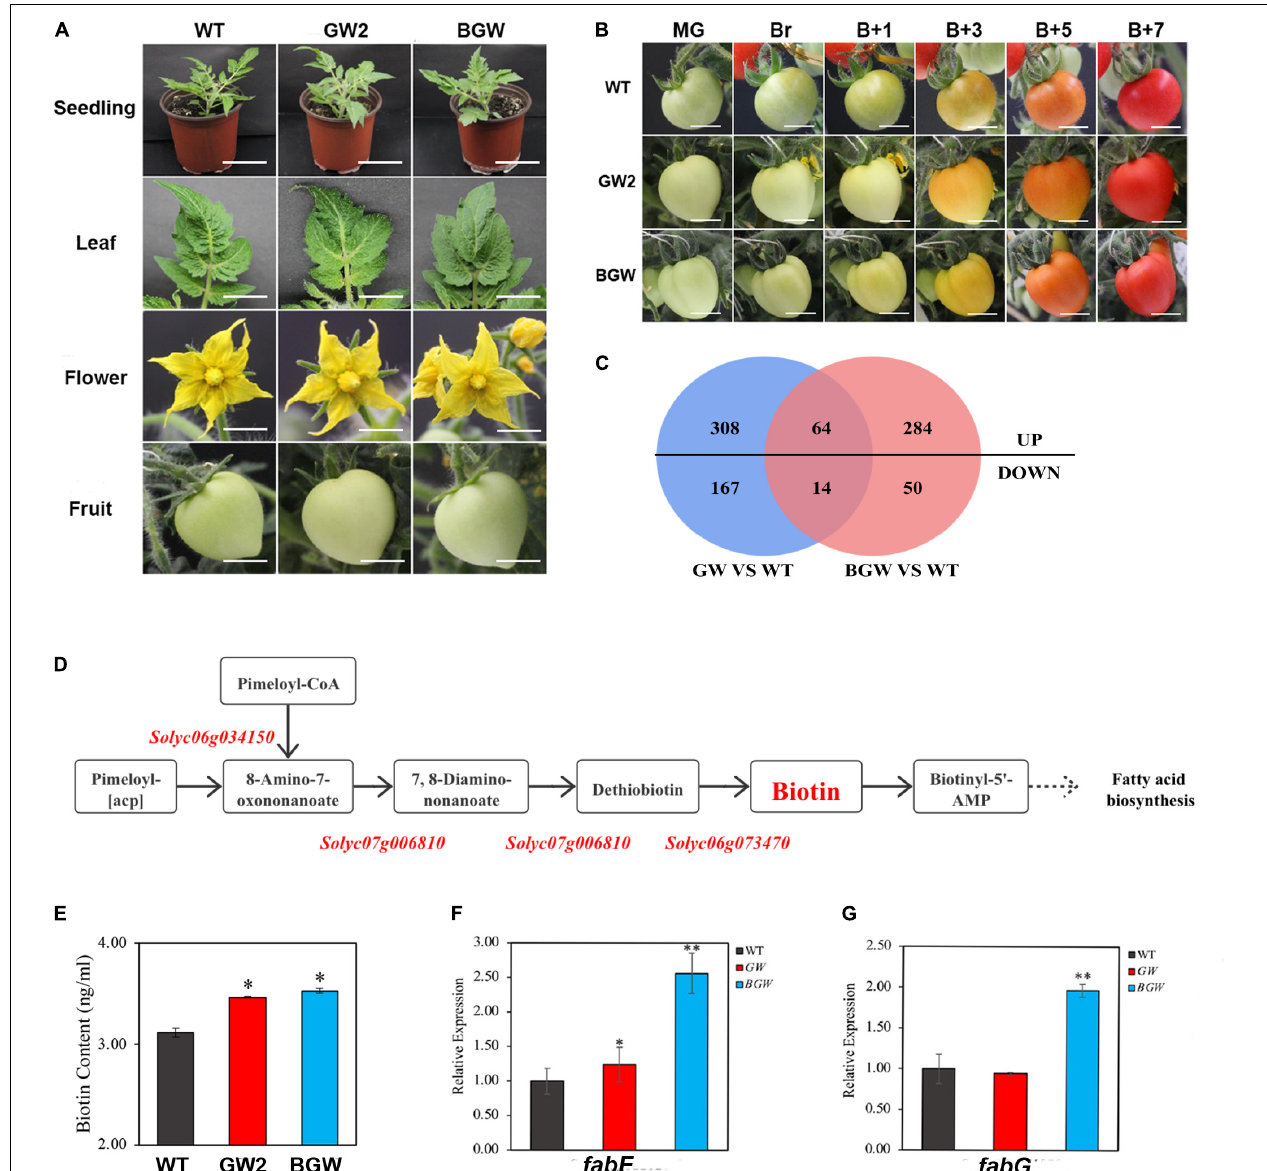
FIGURE 5 | Phenotype and transcriptomic analysis in GW2 lines and BGW lines. (A,B) Phenotype comparison among GW2, BGW, and WT lines during growth and development and fruit ripening. A, Different tissues were shown, including 14-day-old seedlings, leaves, flowers in full bloom, and green fruit. B, Fruit ripening stage of WT, GW2, and BGW lines at different time points. (mature green, MG; breaker, Br; breaker + 1 days, B + 1; breaker + 3 days, B + 3; breaker + 5 days, B + 5; breaker + 7 days, B7). (C) Venn diagrams showing the statistical counts of differentially expressed genes identified in GW2 and BGW compared with WT. (D) Diagram of the biotin synthesis pathway in tomato, all three critical genes were marked in red. (E) Results of biotin content measured in leaves from WT, GW, and BGW lines. Relative gene expression in biotin-related downstream pathways, such as fatty acid biosynthesis (F,G) , was measured in leaves from GW2 lines or BGW lines. Scale bars: A, Seedling, 5 cm. A, Leaf, flower, and fruit, and B, 1 cm. Asterisks indicate significant differences ( ∗ p < 0.05, ∗∗ p < 0.01) in comparison with